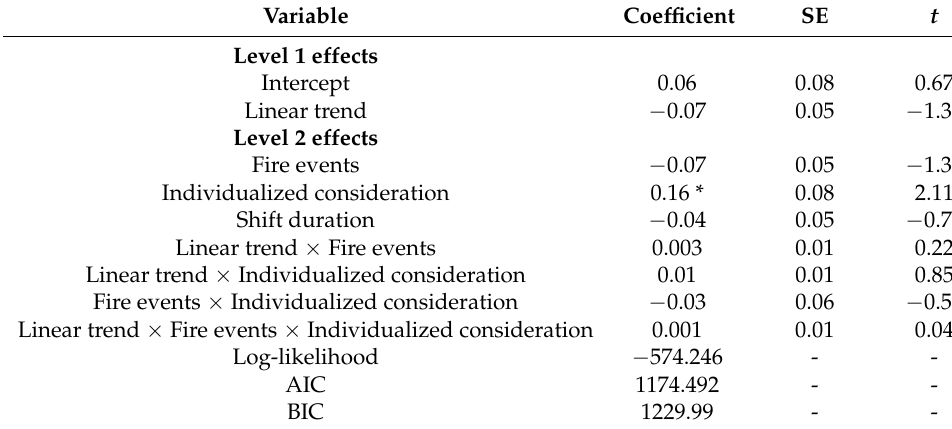
Table A4. Fire Events and Individualized Consideration Predicting Change in Work